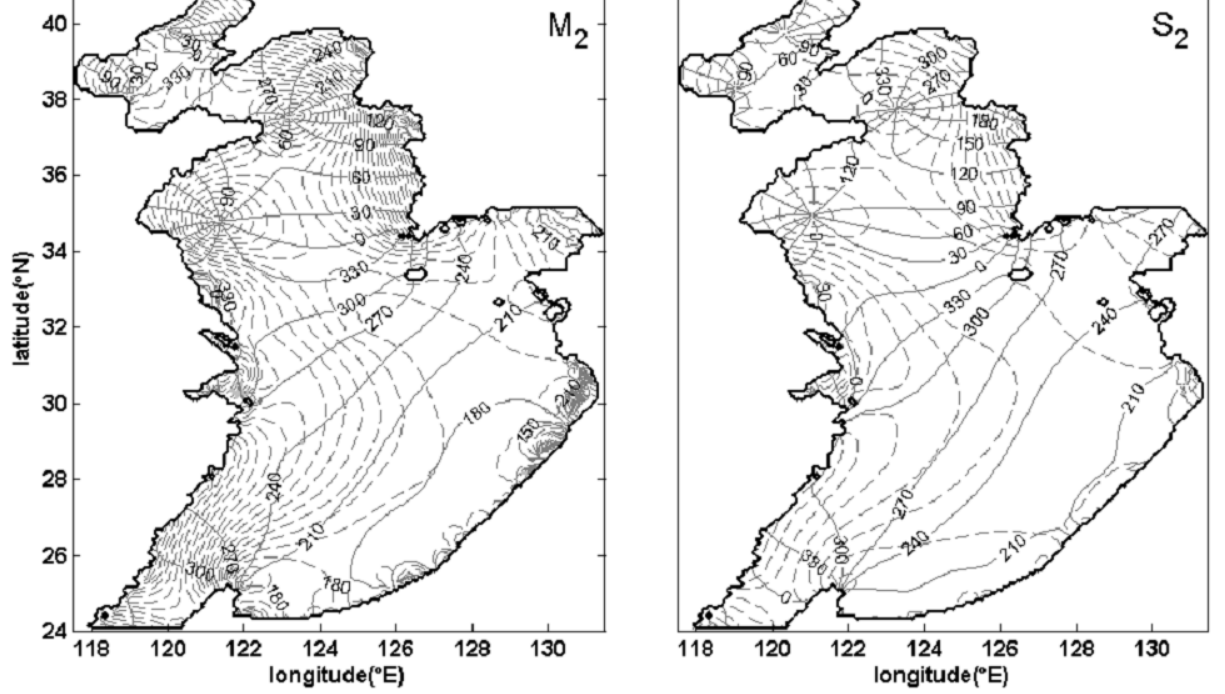
Figure 3. Computed cotidal charts for the M 2 and S 2 constituents. Solid line denotes the phase-lag (in deg), and dotted line denotes the amplitude (in m) in [0.1 3.0] m, taken 0.1 m as the interval length.